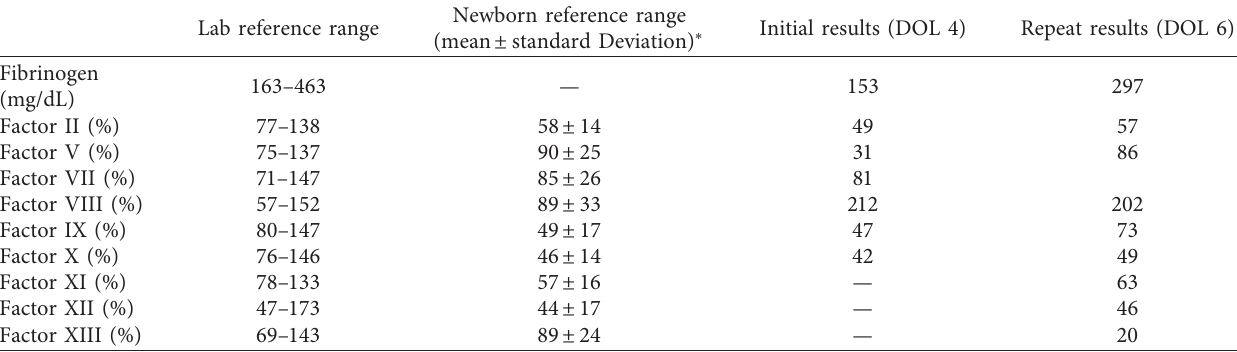
Table 3: Coagulation factor levels